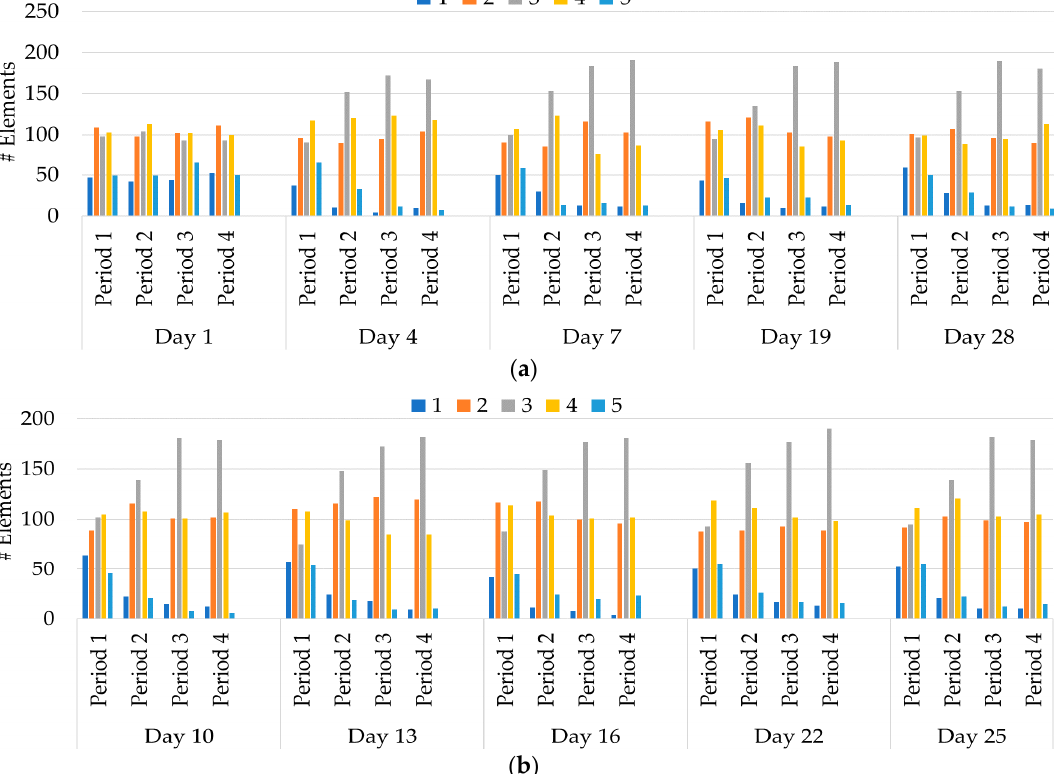
Figure 3. Number of elements per Reliability Rate group considering the Initial Rate being: ( a ) DR event 1; ( b ) DR event